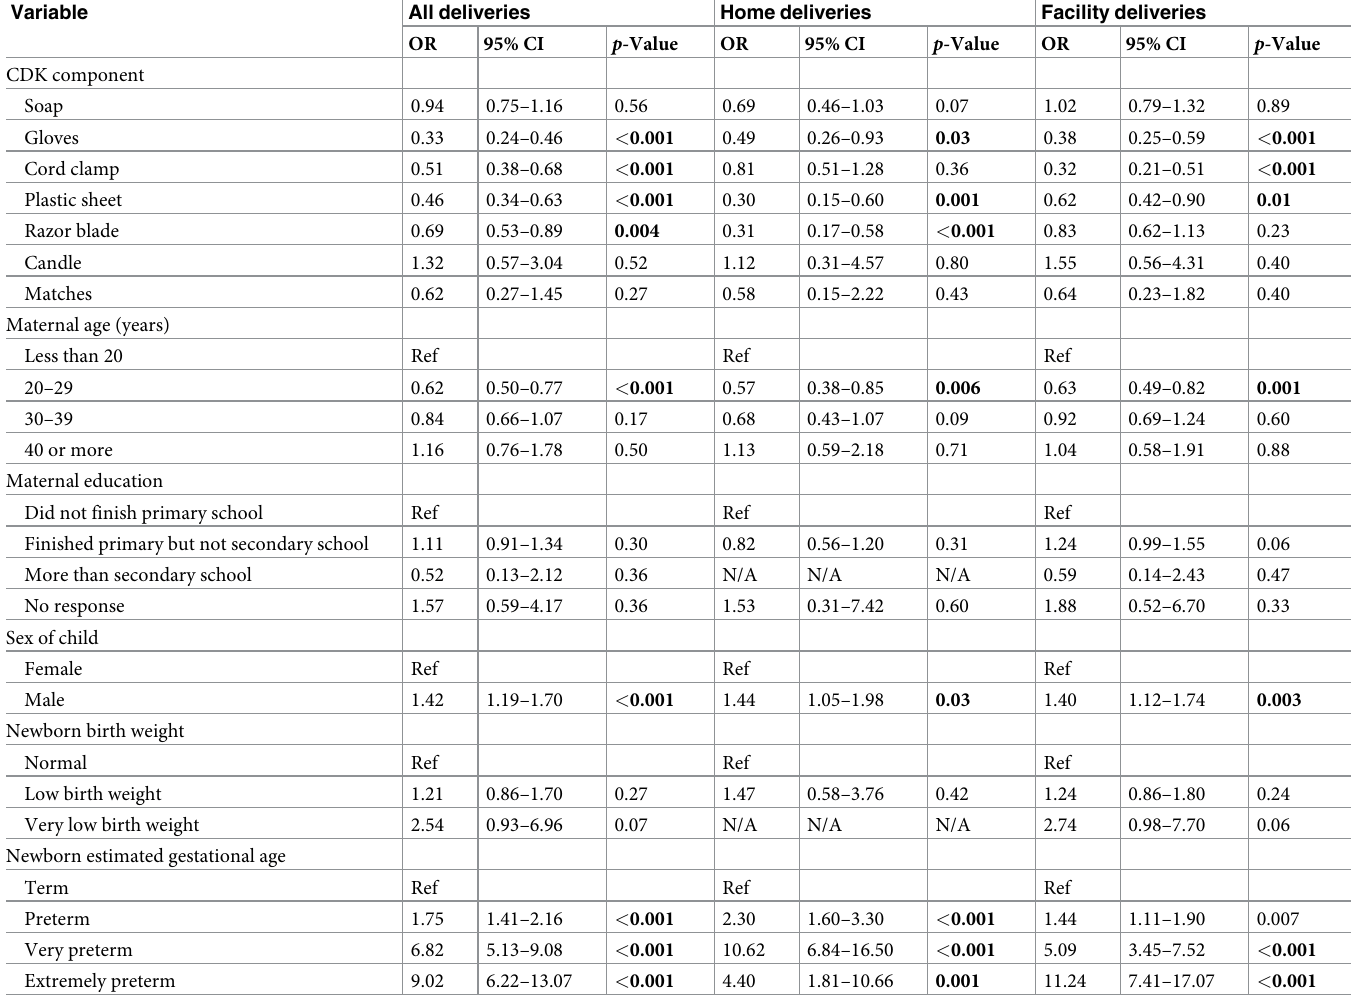
Table 4. Adjusted logistic regression—association between CDK components and newborn mortality stratified by delivery